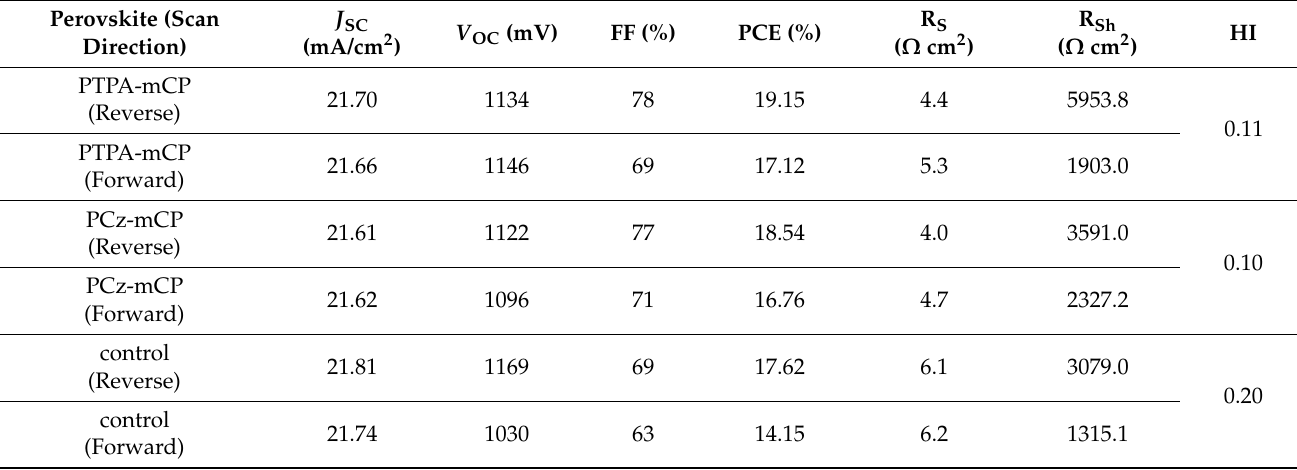
Table 1. Comparison of photovoltaic parameters of the highest efficiency devices based on perovskite films with or without polymer- templated